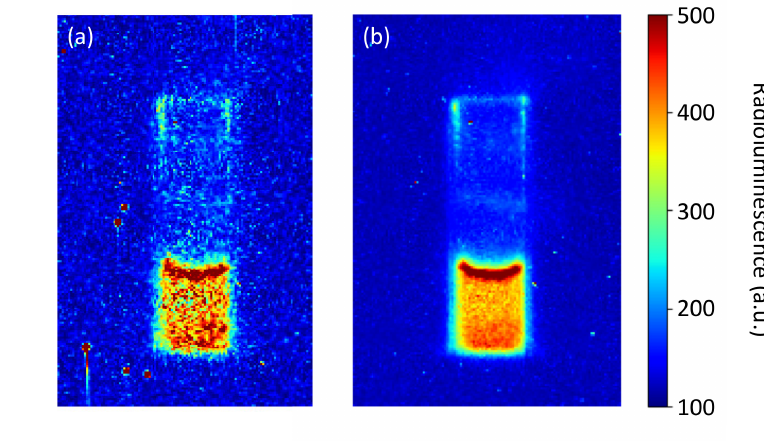
Figure 2. Demonstration of the post-processing using 30 images with exposure times of 60s each. ( a ) A single capture, raw data. The cuvette and the liquid are clearly visible, hot pixels appear as red dots. ( b ) The pixel-wise median over a total of 30 images. The z-scale shows raw pixel